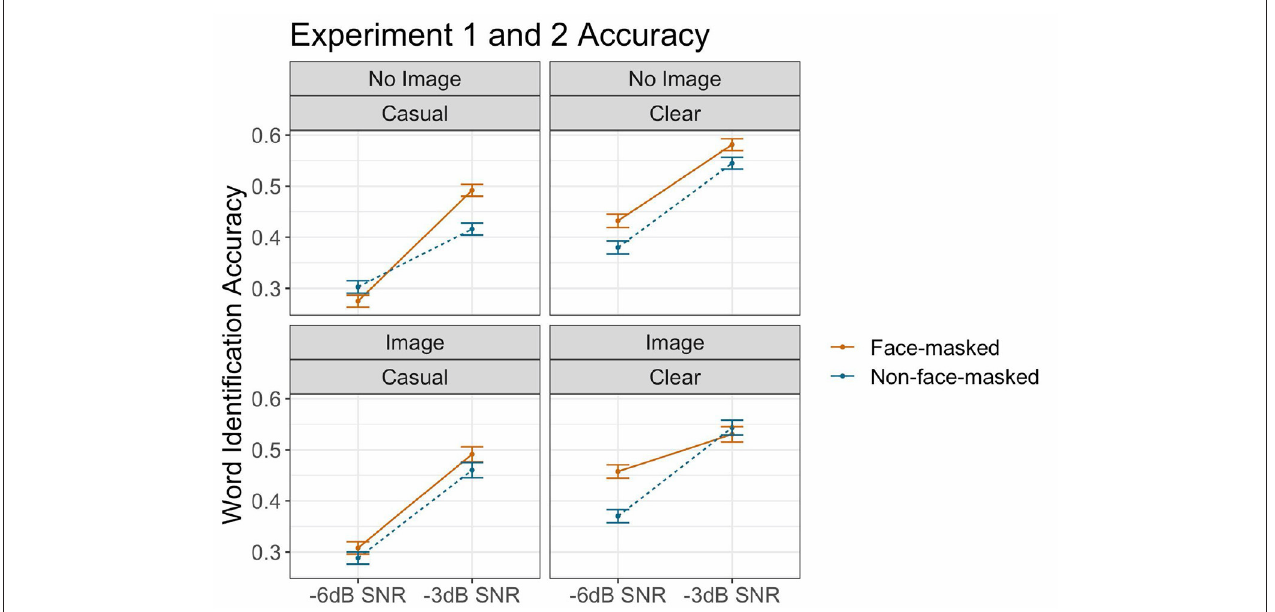
FIGURE 5 | (Color online) Target word identification accuracy for both experiments. The x-axis shows signal-to-noise SNR ( − 6 dB, − 3 dB). The points show the grand mean for each SNR, with the lines indicating differences for SNR for face-masking condition (solid orange line = face-masked; dotted blue line = non-face-masked). Image and speech style conditions are faceted. The error bars indicate standard errors of the mean.